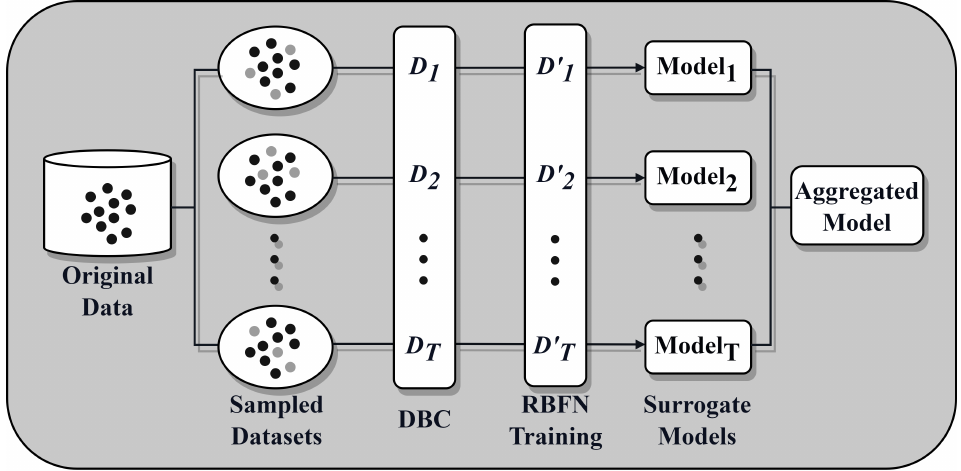
Figure 3. The procedure of W-bagging. Algorithm 2